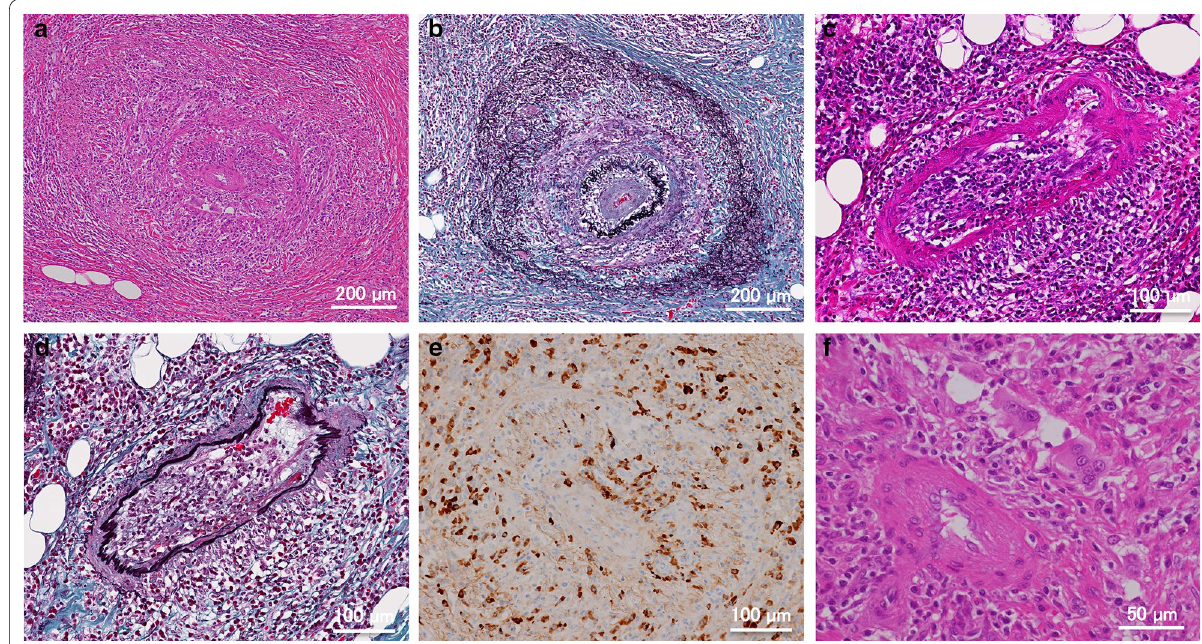
Fig. 4 a , c Obliterative arteritis of a small-sized artery shows abundant lymphoplasmacytic infiltrate within the expanded intima and media (HE; original magnification, a 100, c 200). b , d Elastica staining is highlighted in the elastic membranes of the artery (Elastica-Masson; × × original magnification, b 100, d 200). e Immunostaining for IgG4 shows IgG4-positive plasma cells infiltrate in the arterial wall (original × × magnification, 200). f Multinucleated giant cells were observed in the inflamed arteries (HE; original magnification, ×